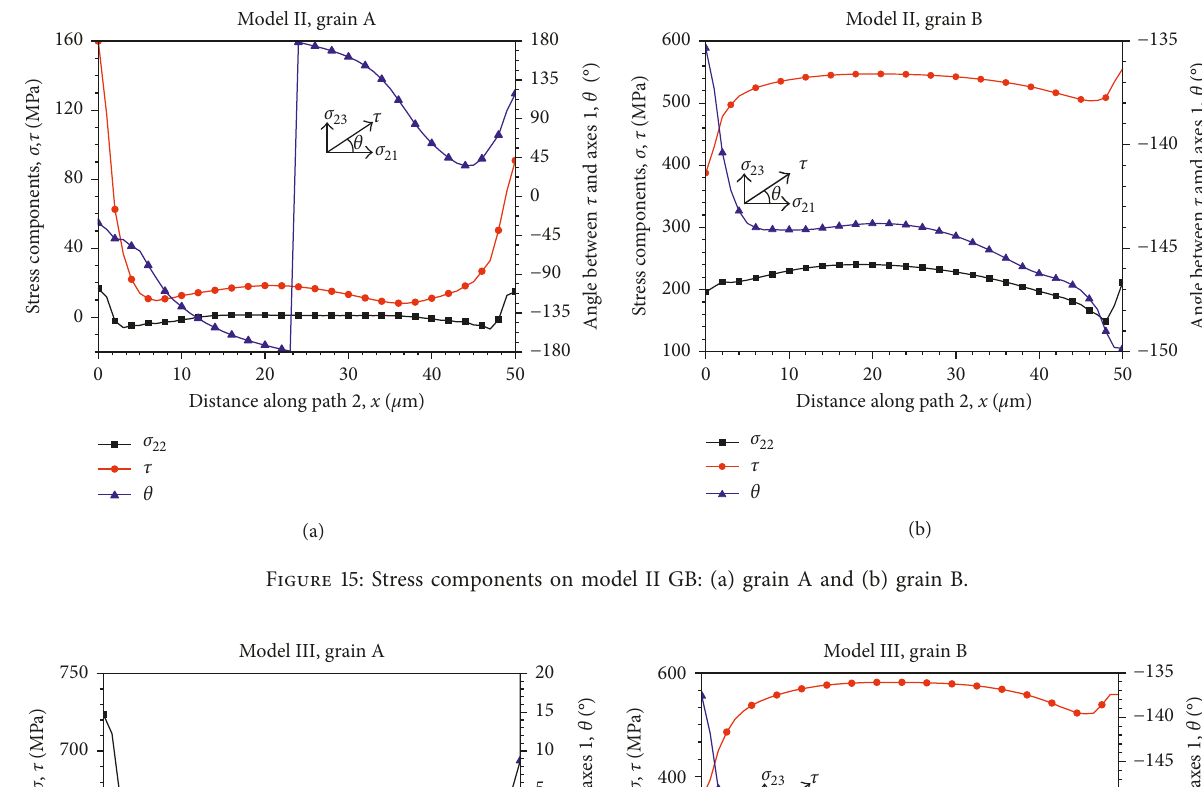
Figure 15: Stress components on model II GB: (a) grain A and (b) grain